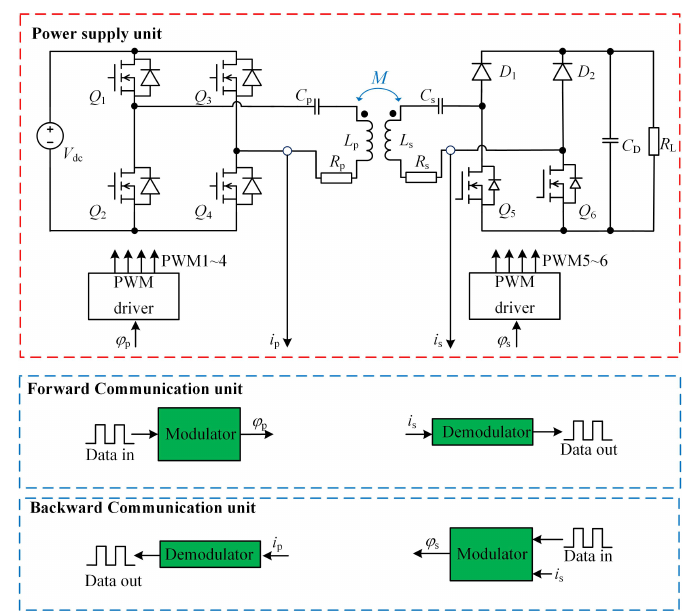
Figure 2. Schematic diagram of the proposed simultaneous wireless power and information transmission (SWPIT) system.